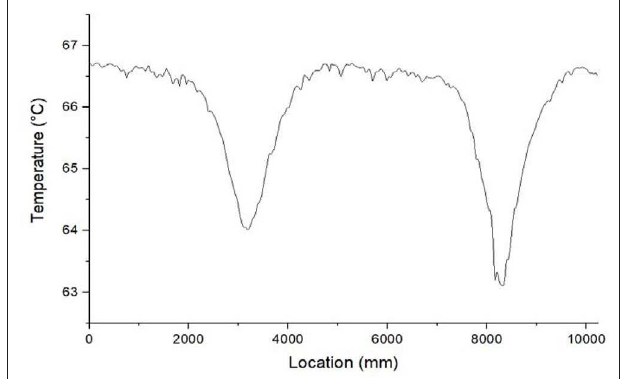
FIGURE 7 | Third-day temperature distribution for concrete shaft with coarse aggregates. The x-axis is the corresponding length of optical fiber spirally wrapped on the rebar